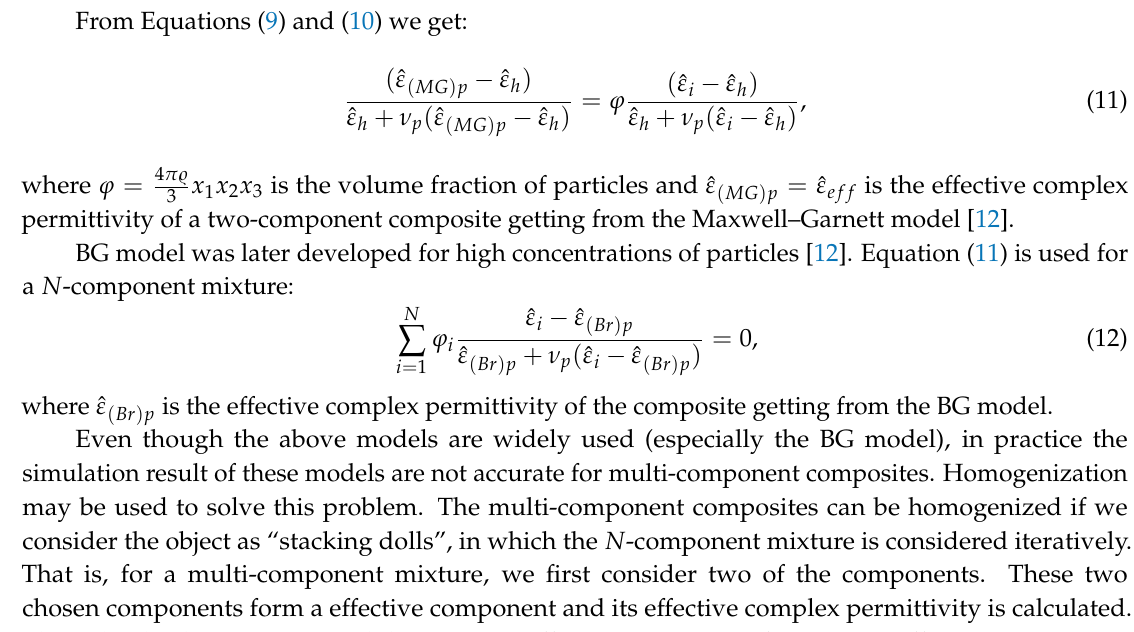
Figure 1. The values of the depolarization coefficient for various forms of particles